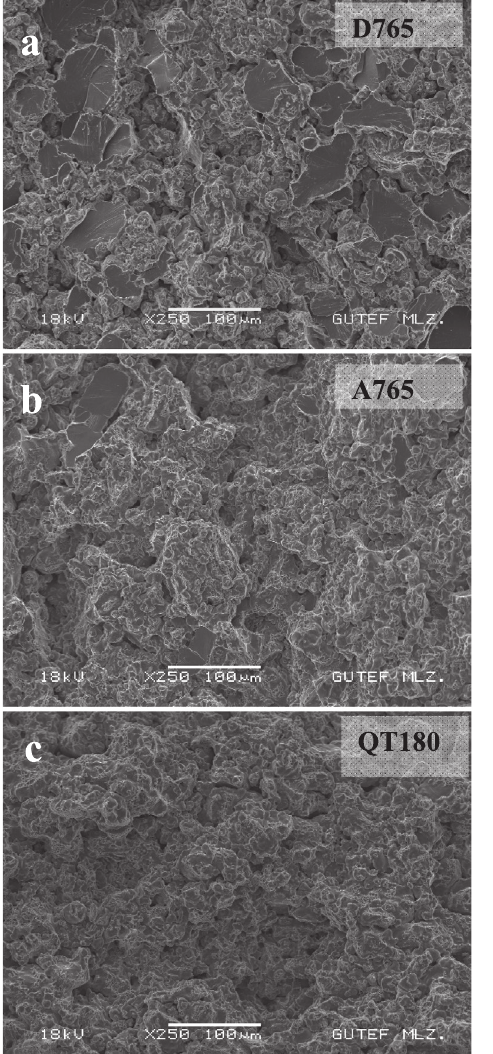
Fig. 3: SEM micrographs of the fracture surface morphologies of the specimens D765 (a), A765 (b) and QT180 (c)